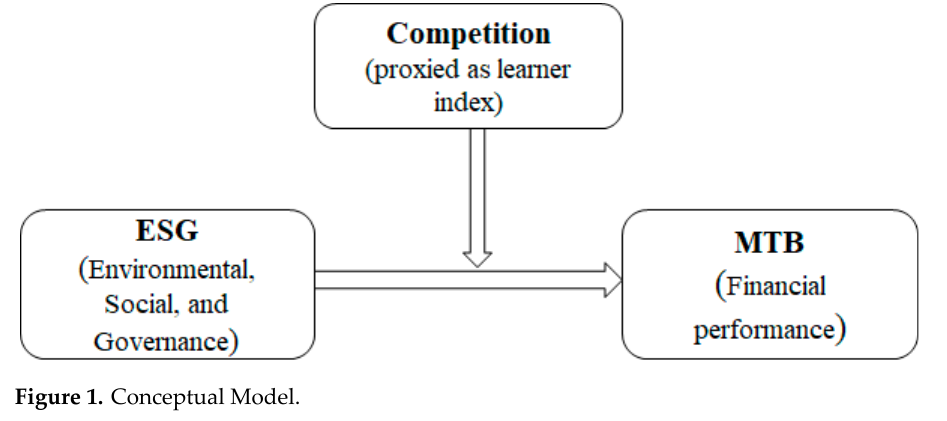
Figure 1. Conceptual Model.